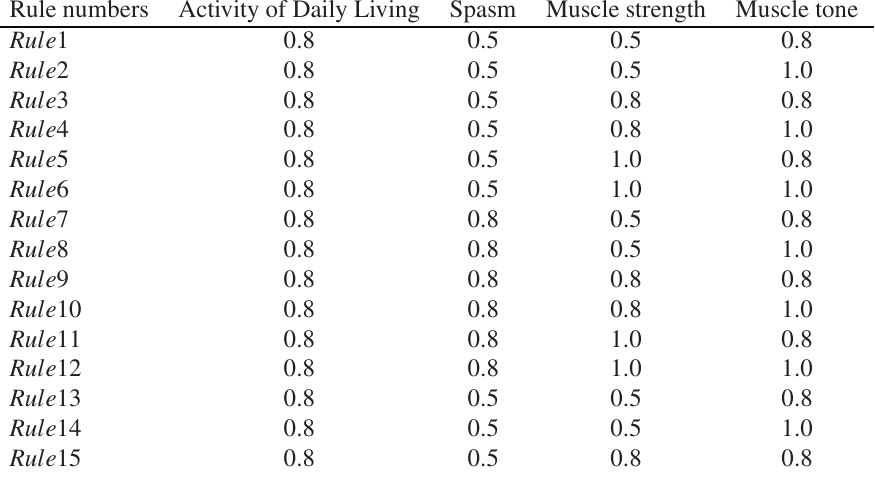
Table A.3. The certainty factor of three